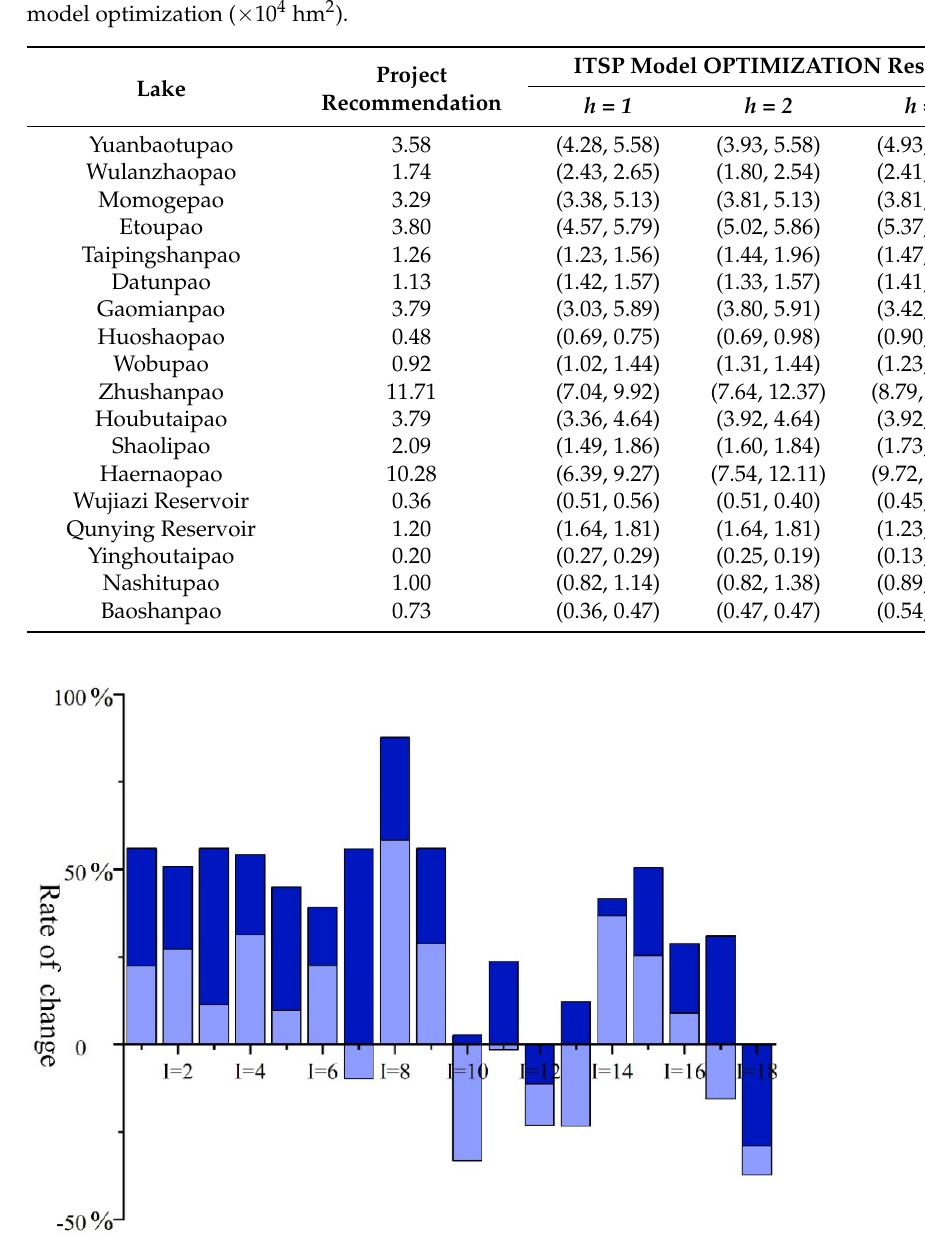
Figure 3. Changes in the respective areas of different functional areas of the lake in the protected area prior to and after model optimization compared to the project recommendation.